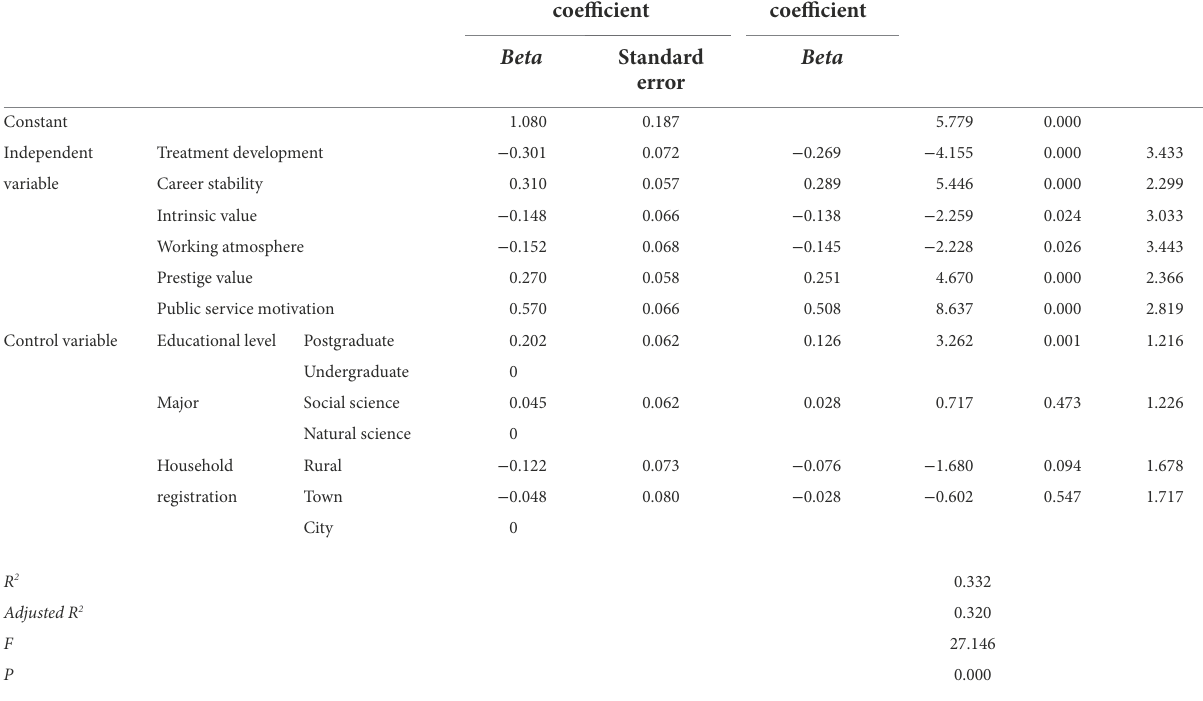
TABLE 7 Linear regression analysis